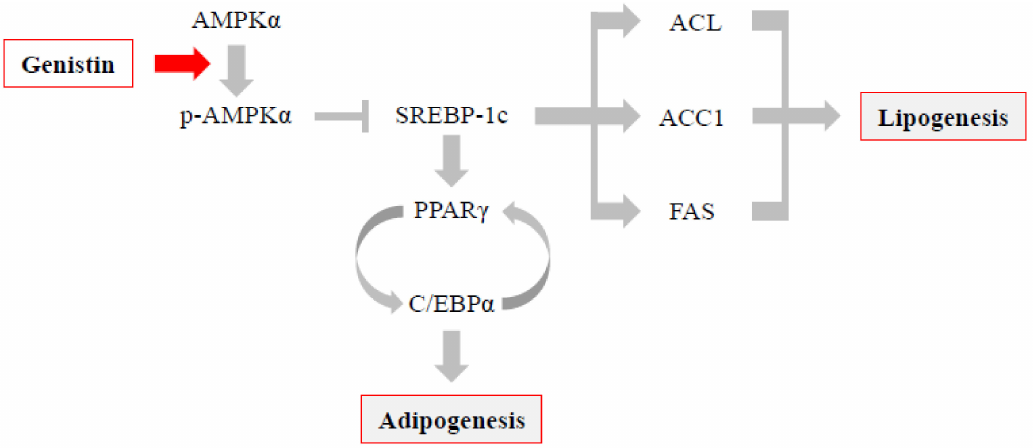
Figure 6. Proposed mechanism of genistin in adipogenesis and